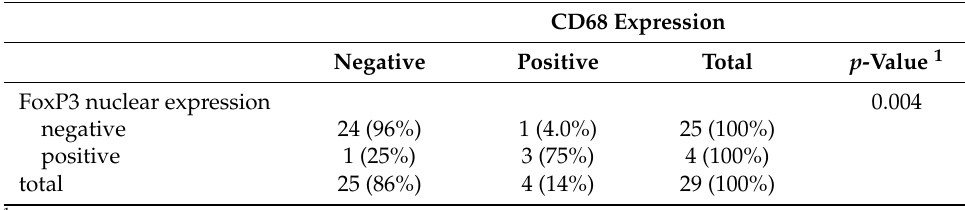
Table 5. Correlation between FoxP3 and CD68 expression in malignant melanoma group.